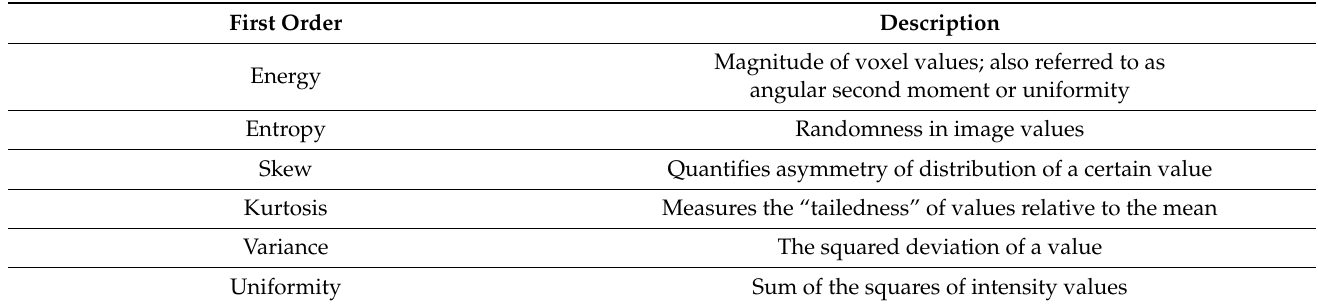
Table 1. Summary of quantitative features used in radiomics